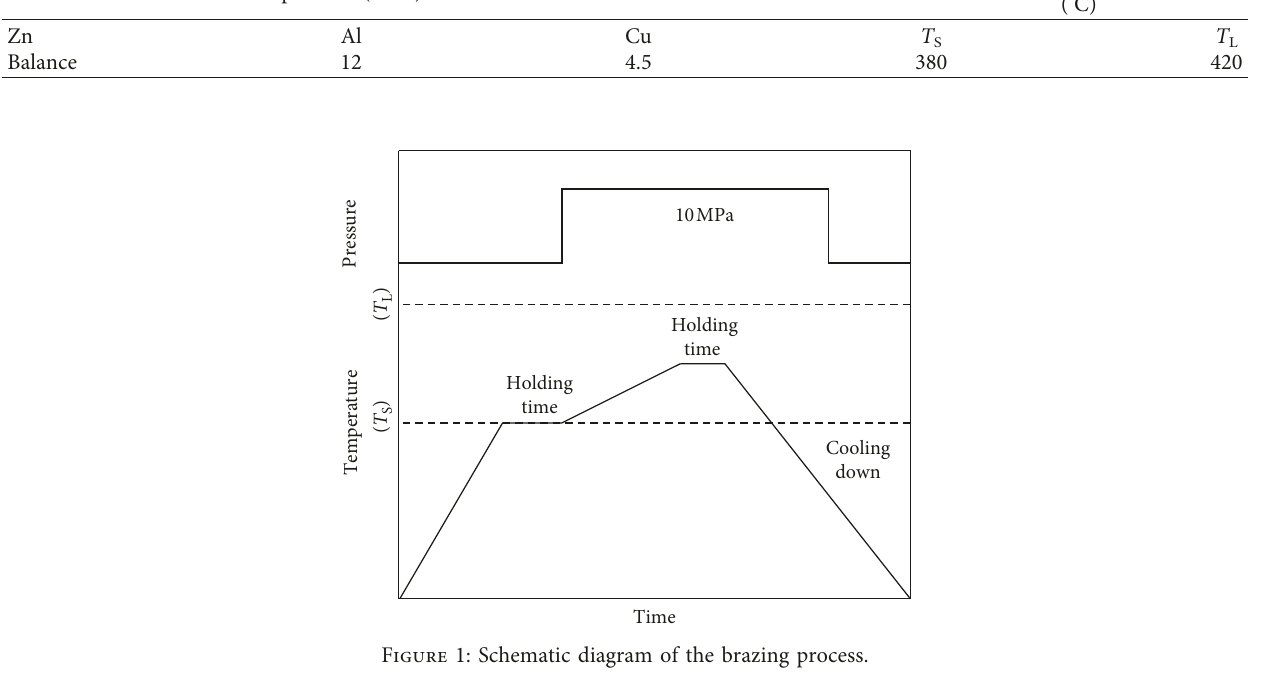
Table 1: Chemical composition and solidus ( T S ) and liquidus temperatures ( T L ) of the filler metals. Composition (wt.%)